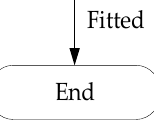
Figure 1. Flowchart of this study.